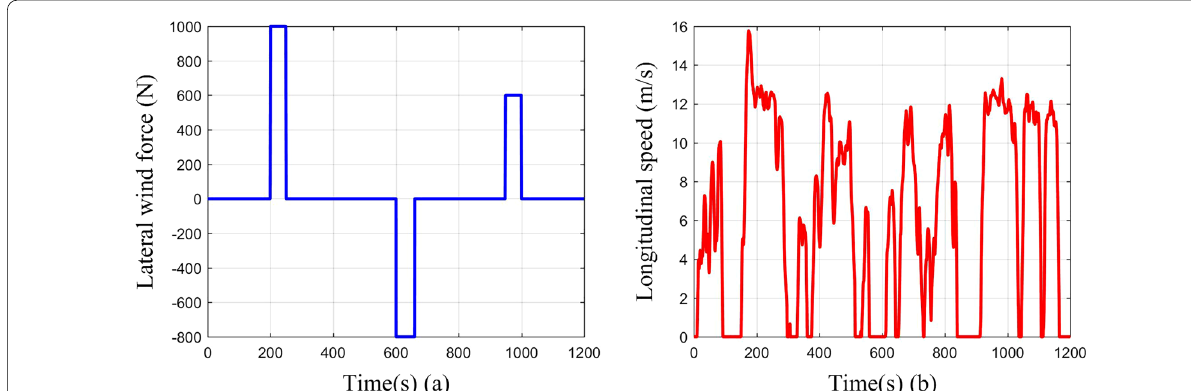
Figure 6 a The external disturbance, b the measured vehicle speed